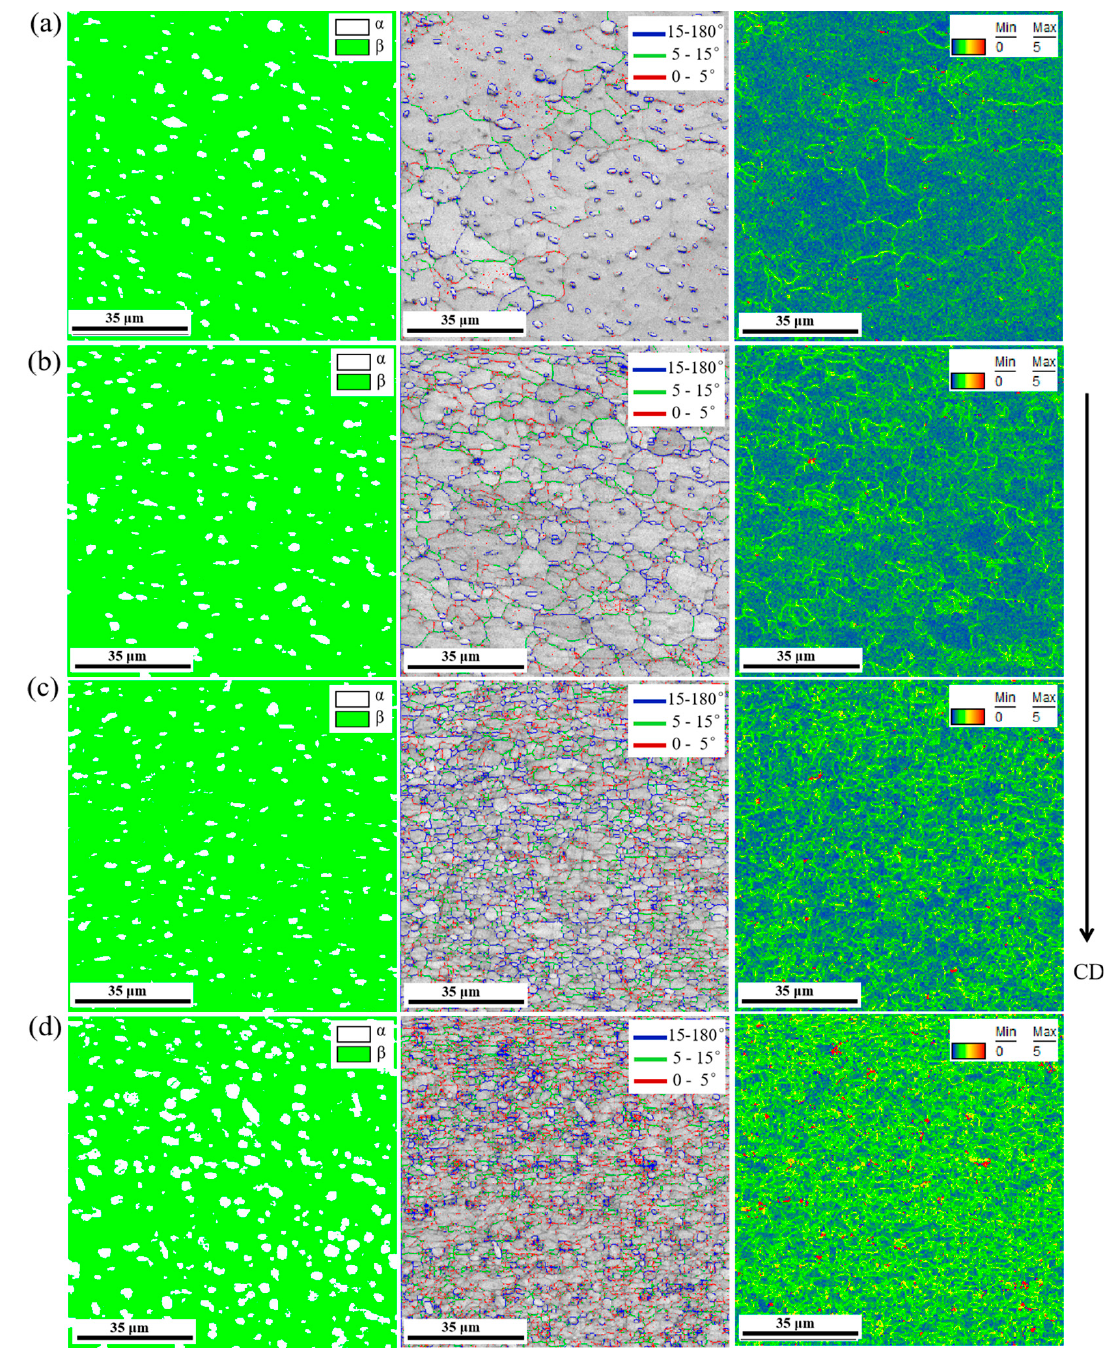
Figure 9. Phase distribution, grain boundary distribution and kernel average misorientation of Ti555211 alloy samples at 850 °C in the case of the various strain rates: ( a ) 0.005 s − 1 ; ( b ) 0.05 s − 1 ; ( c ) 0.5 s − 1 ; ( d ) 5 s − 1 .